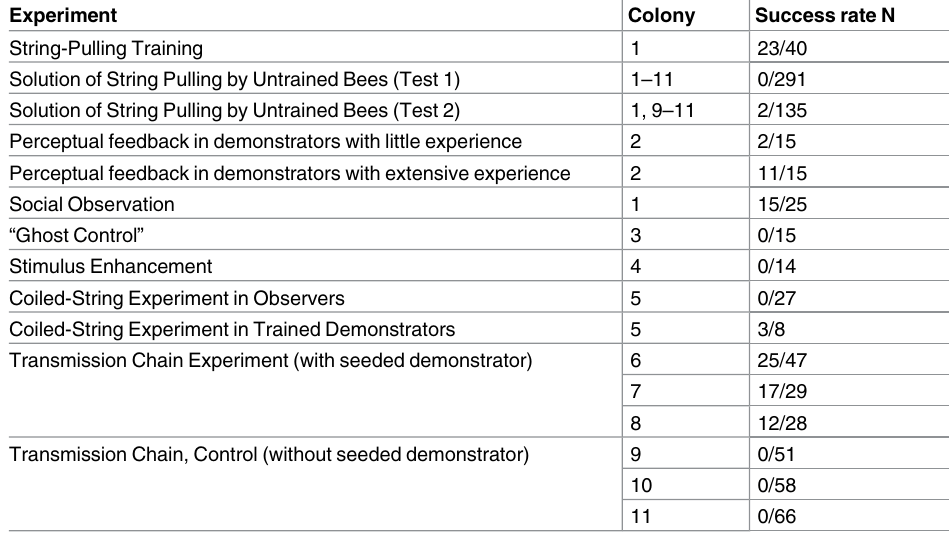
Fig 2. Social transmission of string pulling. (A) Arena set up for the observation of string pulling.(B) The varioustesting procedures. Tests 1 and 2 were identicaland consisted of giving 5 min to individualbees to solve the string pullingtask. After havingbeen trained to forage from blue artificial flowers, bees were tested a first time (Test 1). Then, demonstrators were trained (see Fig 1) and used to displaystring pulling(two instances, straight strings) duringeach of five foragingbouts to individual observers( n = 52) placed in a transparent Plexiglascage. After the observation phase, 25 observerswere tested again with the straight- string task (Test 2) and 27 with the coiled-stringtask. Fifteen different bees observedthe flower moving without visibleactor so that a forager could then obtainthe sucrose solution (“Ghost control”) and, where tested, with the straight-string task subsequently. Untrainedbees ( n = 25) were also tested a second time with string pulling.(C) Percentageof successful untrained, social, and nonsocialobserverbees in Tests 1 and 2. Asterisk: Fisher’s exact test, p (cid:20) 0.0001. Double S: McNemar test, χ 2 1 = 13.067, p < 0.001. (D) Mean ± s.e. (s) latency in accessing the reward in untrainedand observerbees. Observers’ latency was not different from that of the two “innovators” (Mann–Whitney U test, U 15 = 6, p = 0.205), (see S1 Data).